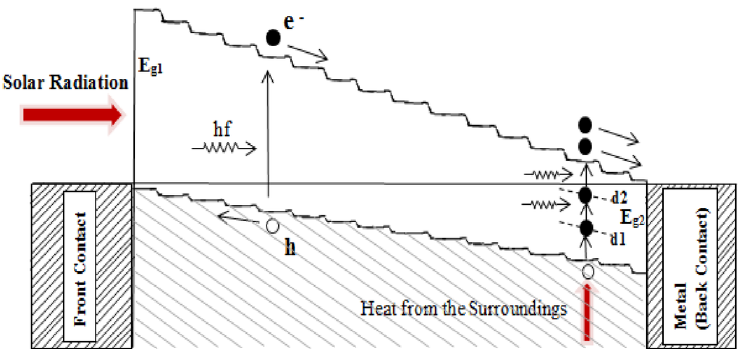
Figure 12. Effective use of naturally occurring defects in semiconductors to create e-h pairs by multistep photon absorption. Photons with energy less than the smallest bandgap (E g2 ) can be harvested using the impurity PV effect [41].